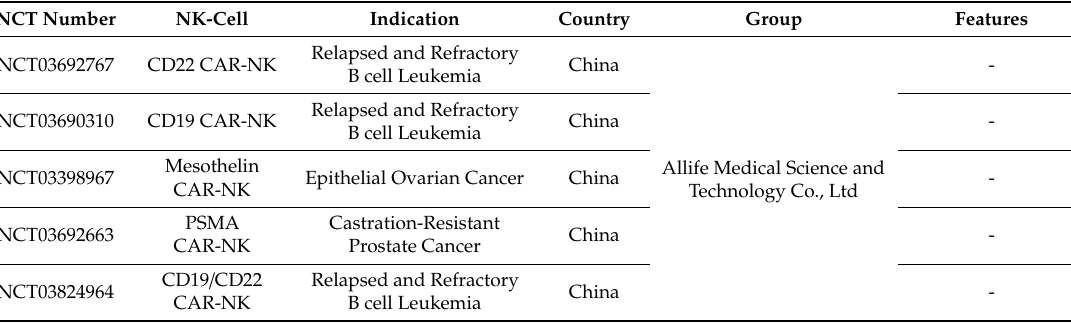
Table 2. Clinical trials of CAR-NK cell therapy. Ten trials are ongoing, and two trials are evaluating fourth generation CAR which expresses inducible apoptotic caspase 9, or inducible apoptotic caspase 9 with